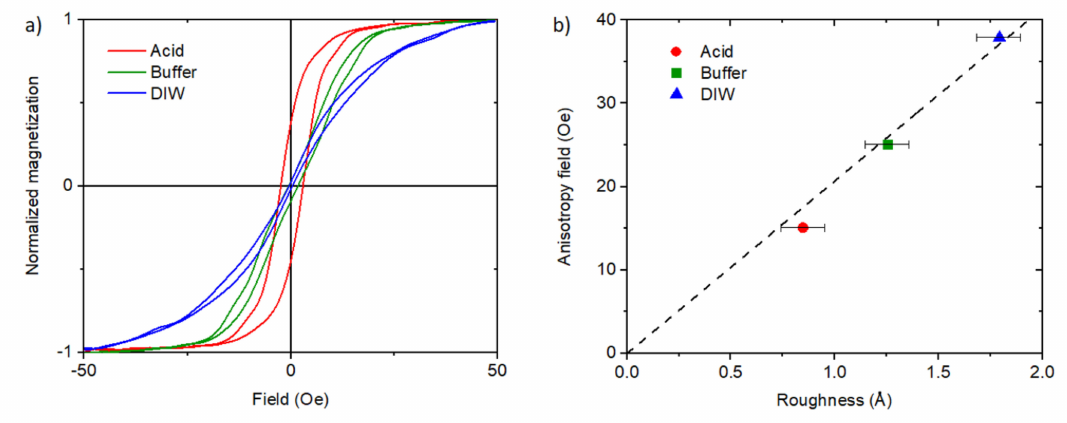
Figure 5. ( a ) The hysteresis loops measured by VSM with the magnetic field perpendicular to the terraces (hard axis) for the samples prepared using various methods. ( b ) The dependence of the anisotropy field (measured for the hard axis) on the roughness with the linear fit to the Arias and Mills dipolar mechanism model. The methods of sample preparation mentioned in the Experimental section are marked as red circle—“acid”, green square—“bu ff er”, and blue